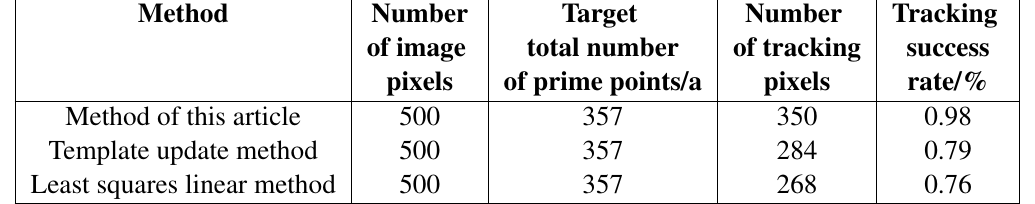
Table 1 Comparison of target tracking success rates of different hitting